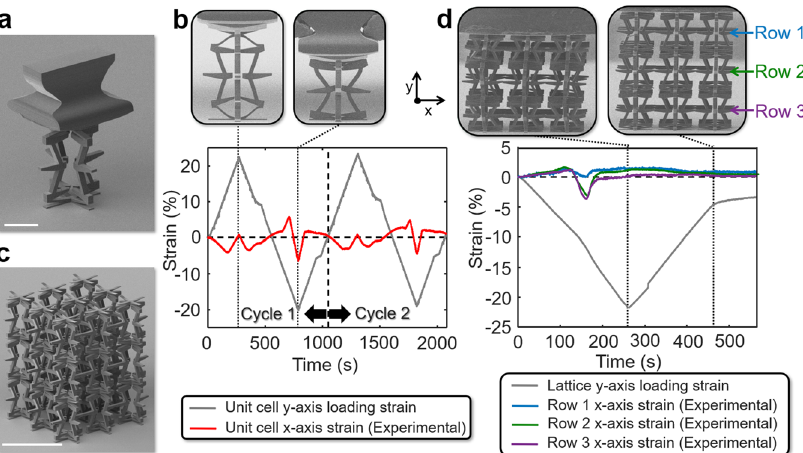
Fig. 8 Fabrication and experimental validation of a micro-scale three-dimensional (3D) unit cell and lattice that achieves an alternating Poisson ’ s ratio. a An additively fabricated micro-scale unit cell with a custom grip to enable its loading in both tension and compression. b The alternating x -axis strain response of the cell being cyclically loaded in tension and compression along the y -axis. c An additively fabricated micro-scale 3 × 3 × 3 lattice of the repeating unit cell design. d The alternating x -axis strain response of each row of cells within the lattice to a compressive y-axis strain load. Scale bar in a , 50 µ m, and in ( c ), 200 µ